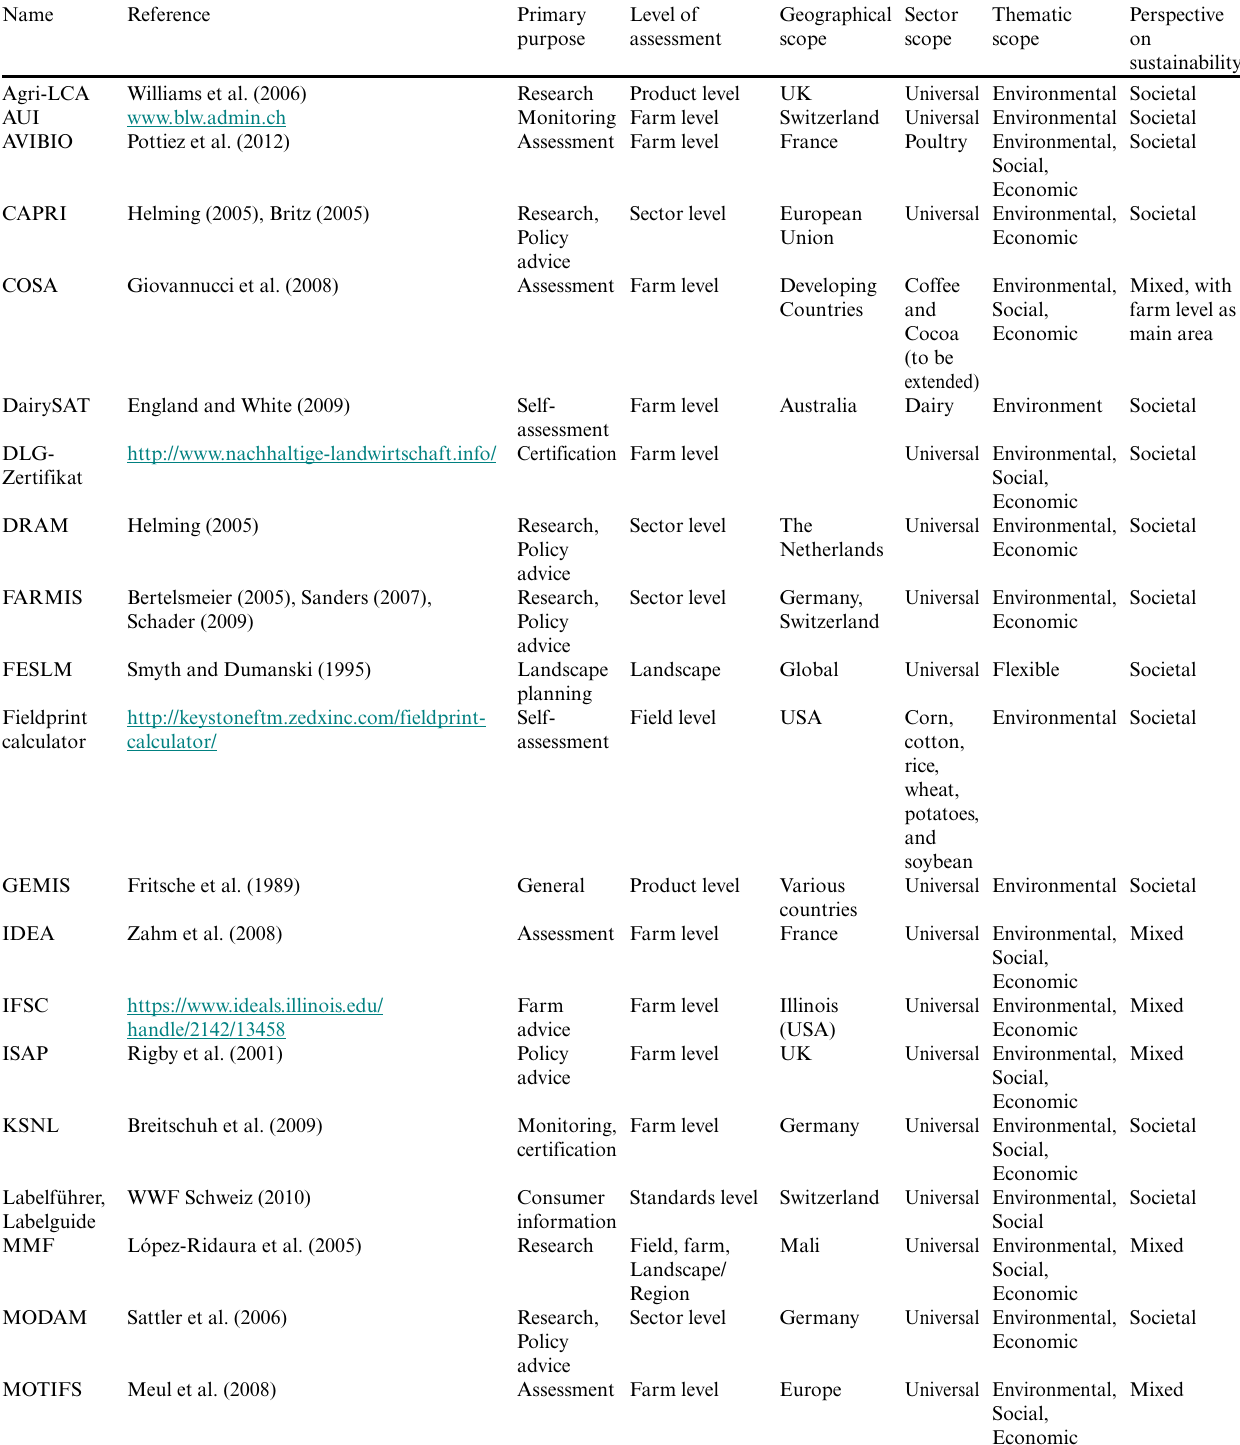
Table 2 . Categorization of sustainability assessment approaches according to their scope. Tools that were selected for the assessment of precision are given in bold